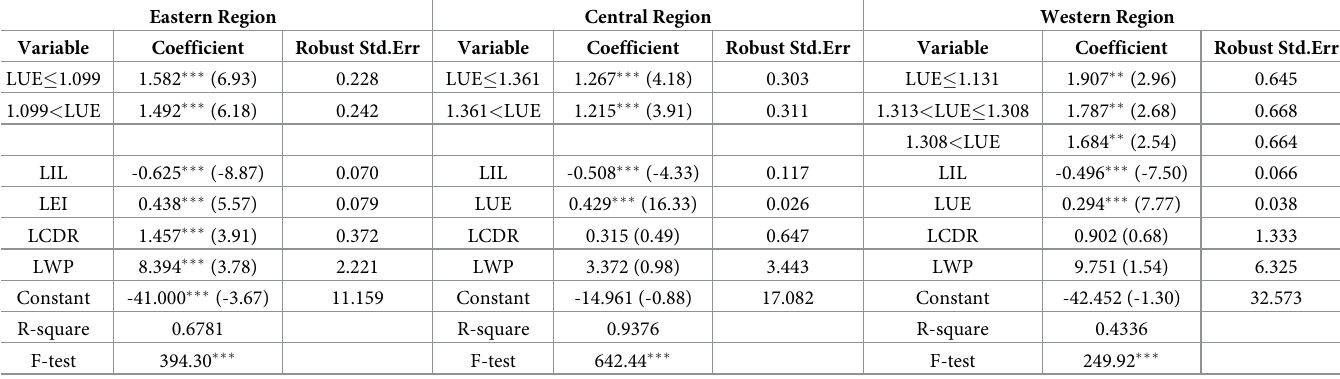
Table 18. Threshold regression